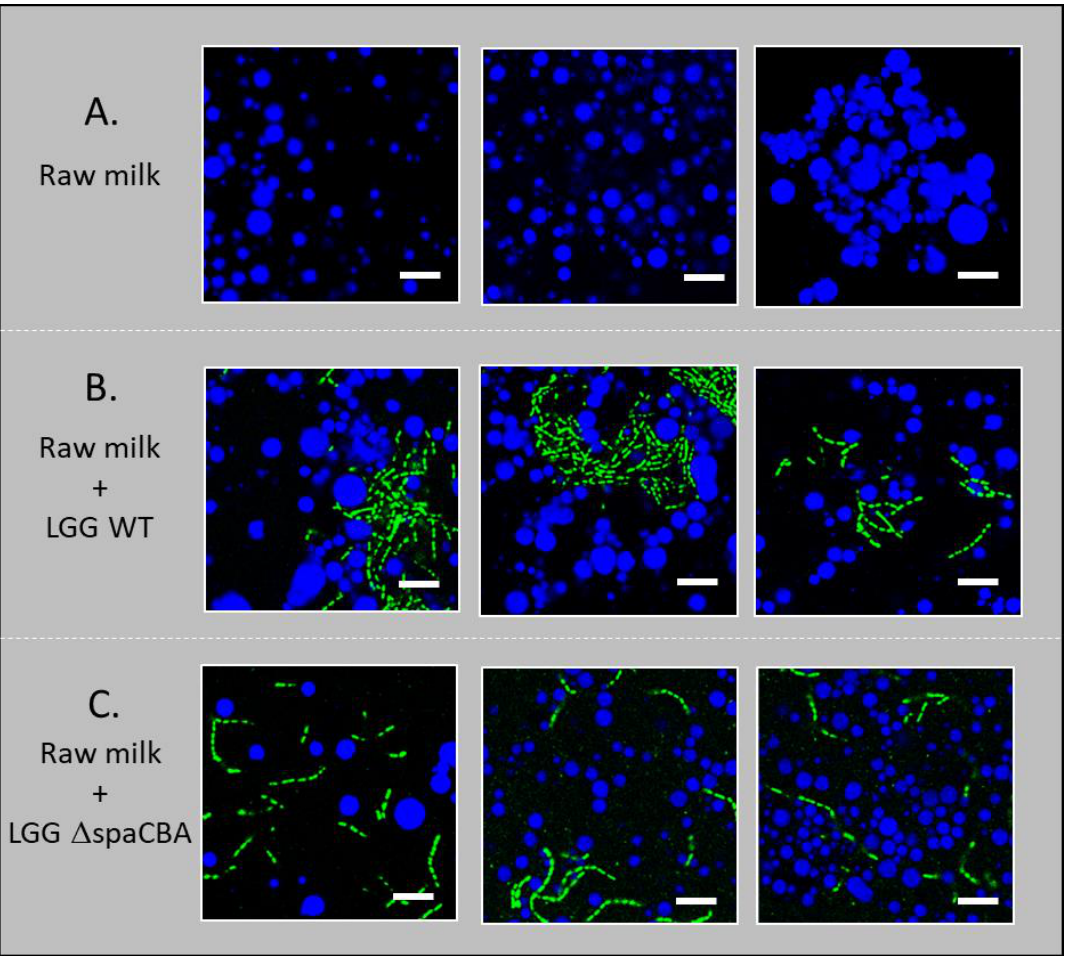
Figure 3. Confocal microscopy images: ( A ) raw milk, ( B ) raw milk with LGG WT and ( C ) raw milk with LGG Δ spaCBA . The fat globules are shown in blue and the bacteria in green. The scale bar represents 10 µm.